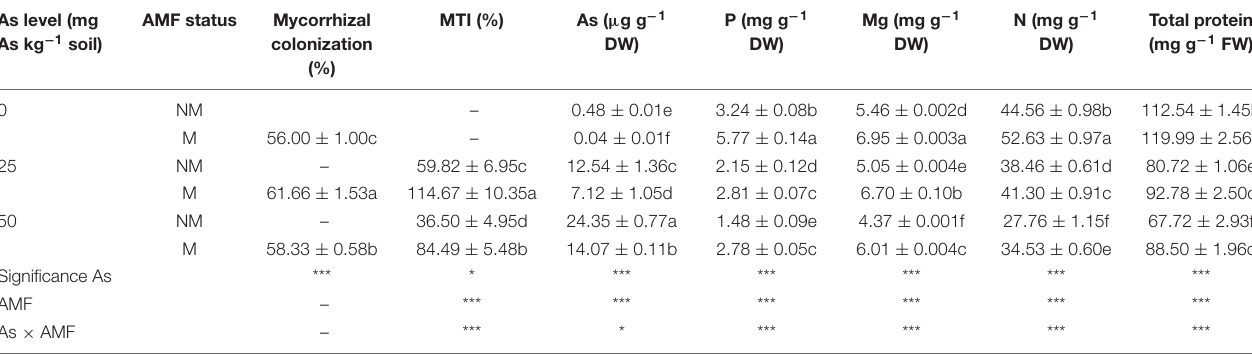
TABLE 1 | Arbuscular mycorrhizal colonization; MTI; and concentrations of As, P, Mg, N, and total proteins in leaves of Triticum aestivum in response to Rhizophagus intraradices inoculation (M, mycorrhizal; NM, non-mycorrhizal) and As addition to the soil. As level (mg As kg − 1 soil)